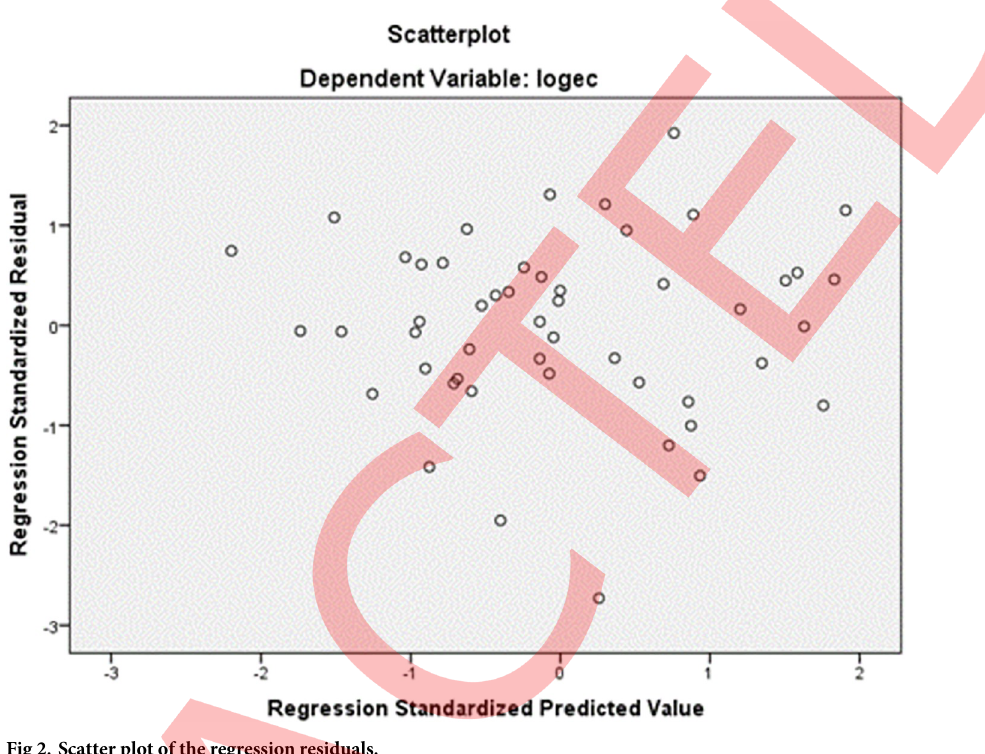
Fig 2. Scatter plot of the regression